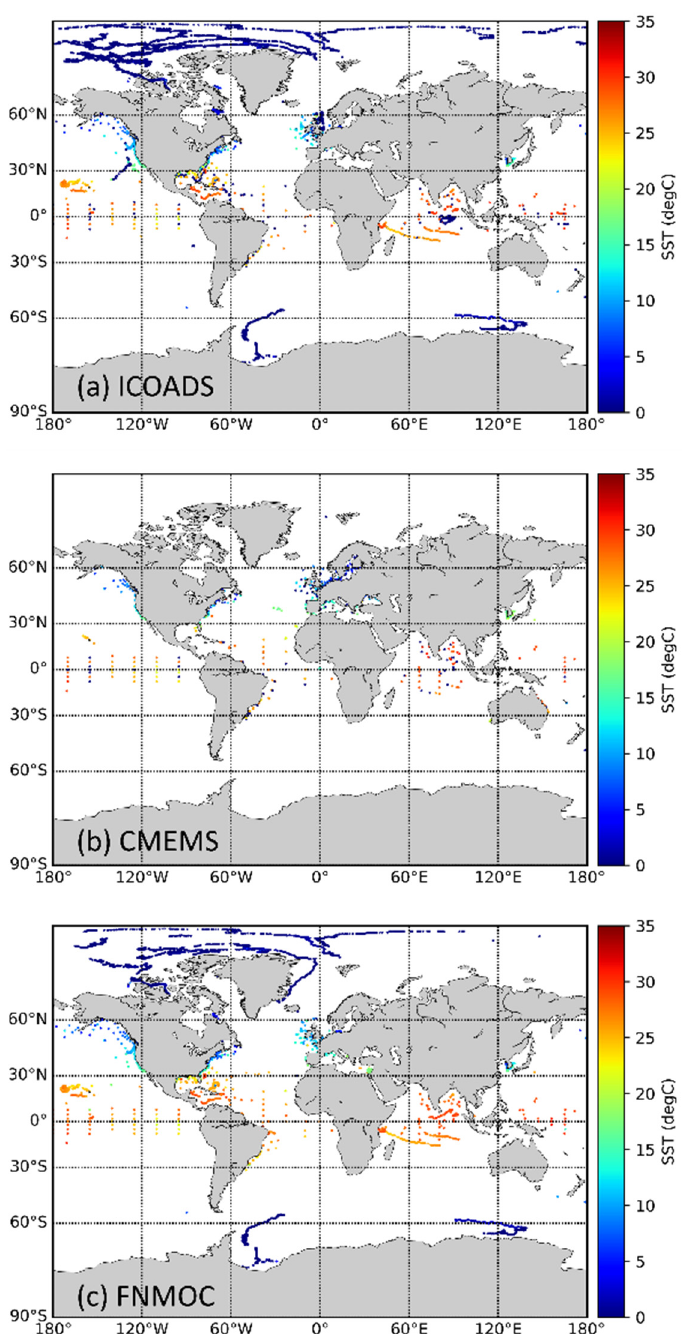
Figure 6. Spatial distribution of all moorings (coastal + tropical) from: ( a ) ICOADS, ( b ) CMEMS, and ( c ) FNMOC. The color bar represents SST.